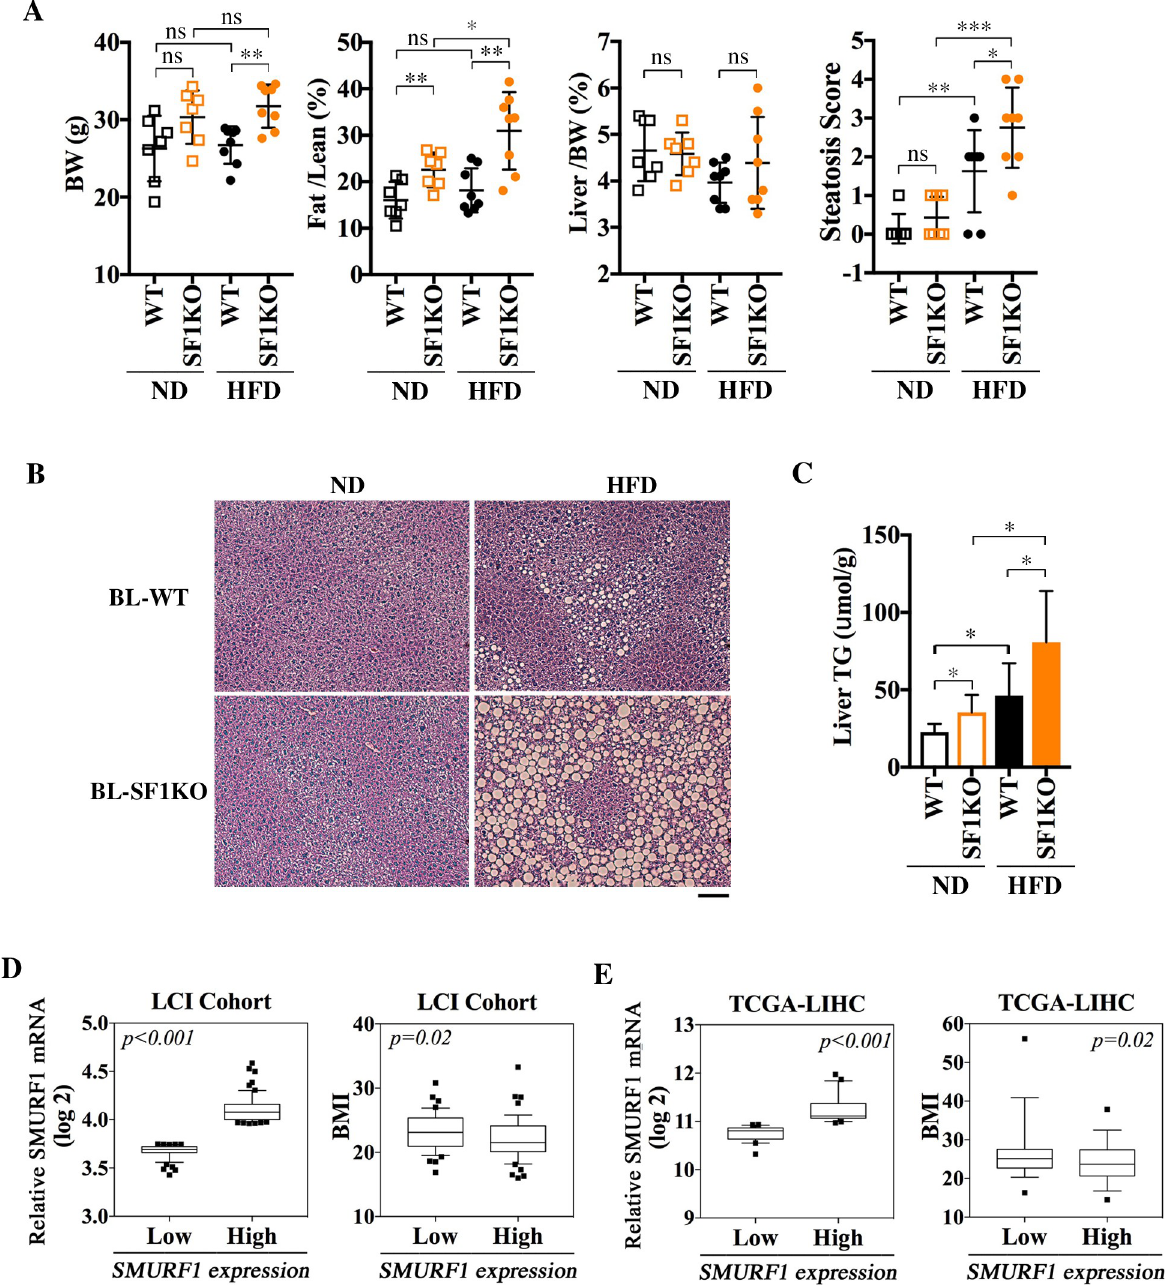
Fig 2. Inverse correlation of low Smurf1 expression to high fat accumulation. (A–C) Loss of Smurf1 exacerbates HFD-induced steatosis in mice. (A) BW, Fat/Lean ratio, Liver/BW ratio, and histological scores of steatosis in male WT and SF1KO mice from BL background reared on either a ND ( n = 7 per group) or HFD ( n = 8 per group), beginning at 10–12 weeks of age for 8 weeks. Liver sections were scored as in Fig 1B. (B) HE staining of representative liver sections of the above BL mice at the end of diet treatment. Bar = 100 μ m. (C) Liver TG levels of BL mice from (A). Data are presented as mean ± SD; statistical significance of differences is indicated as � p < 0.05, �� p < 0.01, ��� p < 0.001. Original raw data can be found in S1 Data. (D–E) Low SMURF1 expression in human livers is inversely correlated to high BMI values. (D) Human liver tissues from the LCI cohort with low levels of SMURF1 expression show a significantly higher BMI than those with high SMURF1 expression. Non-tumor liver samples from the LCI cohort were grouped into SMURF1 High (top 25%, n = 61) and SMURF1 Low (bottom 25%, n = 59) groups. (E) Inverse correlation between SMURF1 low and BMI high was also observed in non-tumor liver samples from the TCGA-LIHC cohort. Non-tumor liver samples ( n = 37) from the TCGA-LIHC cohort were grouped into SMURF1 High (above the median, n = 18) and SMURF1 Low (below the median, n = 19) groups. Data are presented using box and whisker plot; centerline represents the median, whiskers represent 10th–90th percentile. Nonparametic t tests between the two groups were performed; p -values are indicated in the graph. BL, mixed black Swiss × 129/SvEv background;